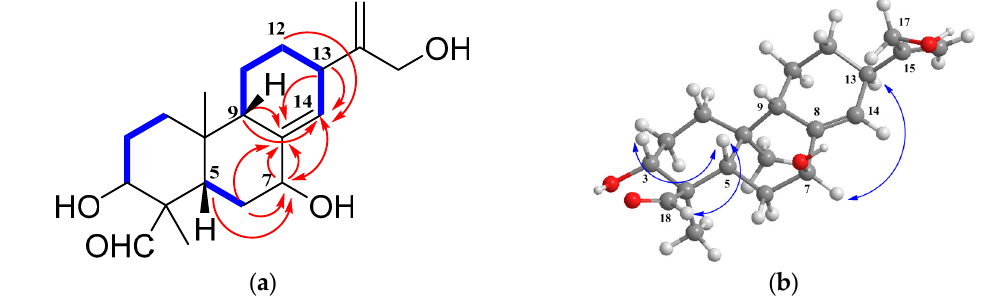
Figure 3. The 2D NMR correlations of compound 3 : ( a ) The 1 H- 1 H COSY (bold) and selected HMBC (arrows) correlations; ( b ) The ROESY correlations.